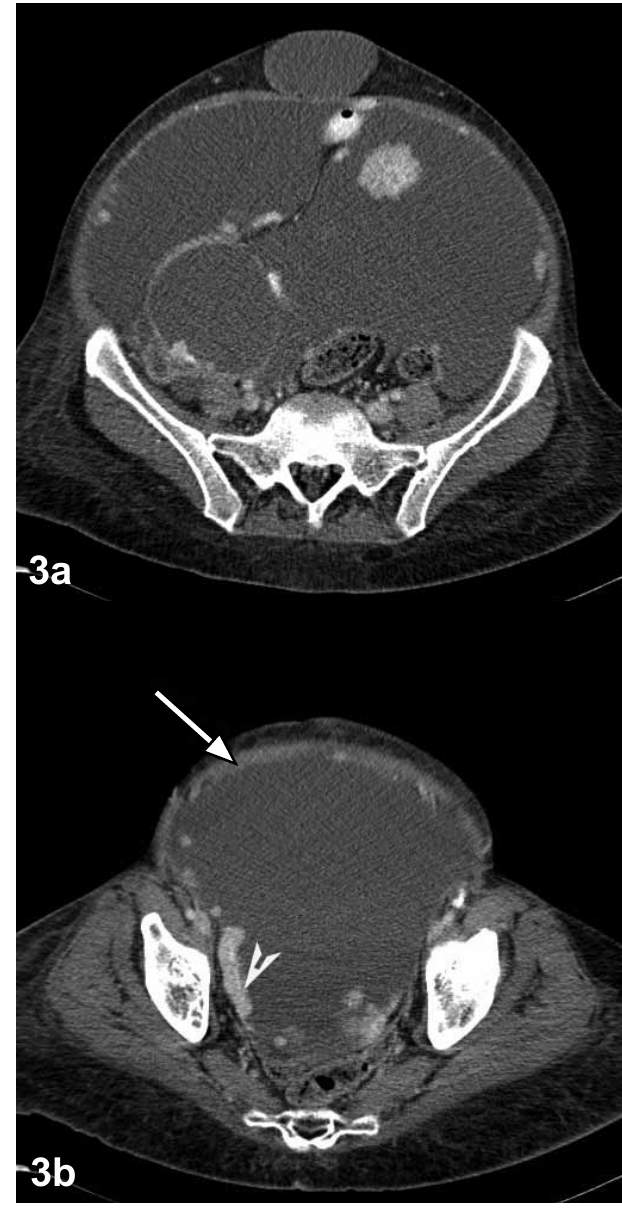
Figs 3a and 3b. Omental thickening (arrow), omental (omental cake) and peritoneal implants (arrow head), and septated ‘pseudo’